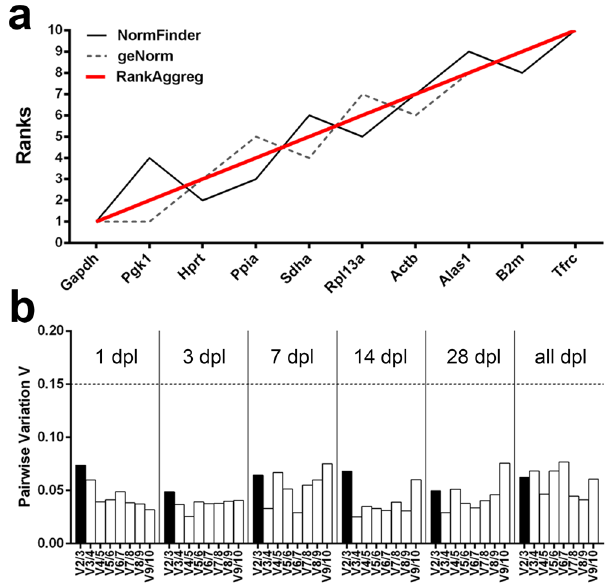
Figure 5. Evaluation of consensus ranking and determination of the optimal number of reference genes by pairwise variation for the granule cell layer after entorhinal denervation. ( a ) Expression stability of candidate reference genes for all time-points after entorhinal denervation analyzed by NormFinder and geNorm. RankAggreg was used for consensus ranking analysis. ( b ) Determination of the optimal number of reference genes recommended for accurate normalization based on the analysis of pairwise variation (V) implemented in geNorm. Every bar represents the change in normalization accuracy by stepwise inclusion of an additional reference gene according to the ranking at specific time points (1, 3, 7, 14, 28 days post lesion, dpl) or for the entire lesion period (all dpl). A cut-off of 0.15 (dashed line) was used below the inclusion of an additional reference gene was not required for proper normalization. Pairwise variation analysis revealed a minimum number of three reference genes needed for accurate